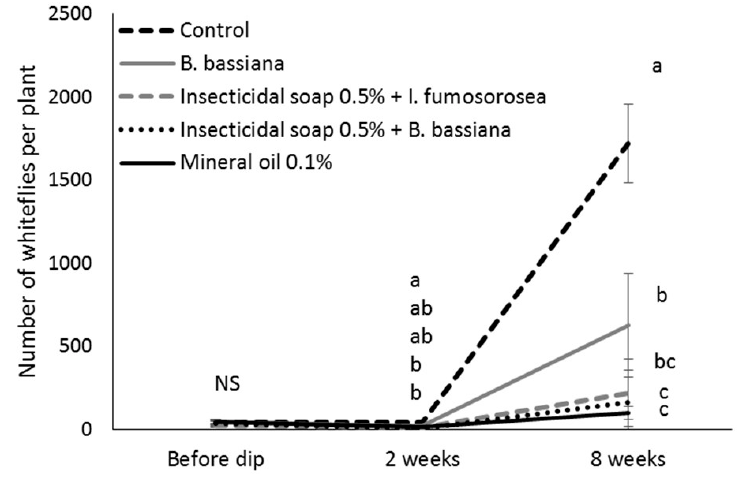
Figure 4. Number (untransformed means ± SE) of Bemisia tabaci on greenhouse poinsettia cuttings before and after dipping in selected reduced risk and biopesticide products. Different letters indicate significant differences among time points and treatments ( α = 0.05).